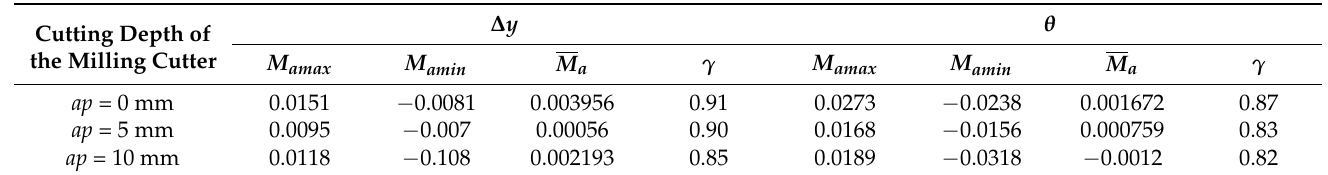
Table 9. The consistency of machining error distribution of surface angular error in the new scheme. Cutting Depth